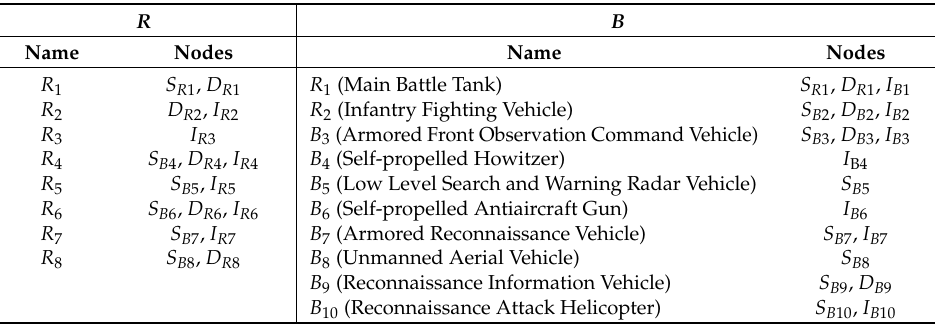
Table 2. WSOS composition.